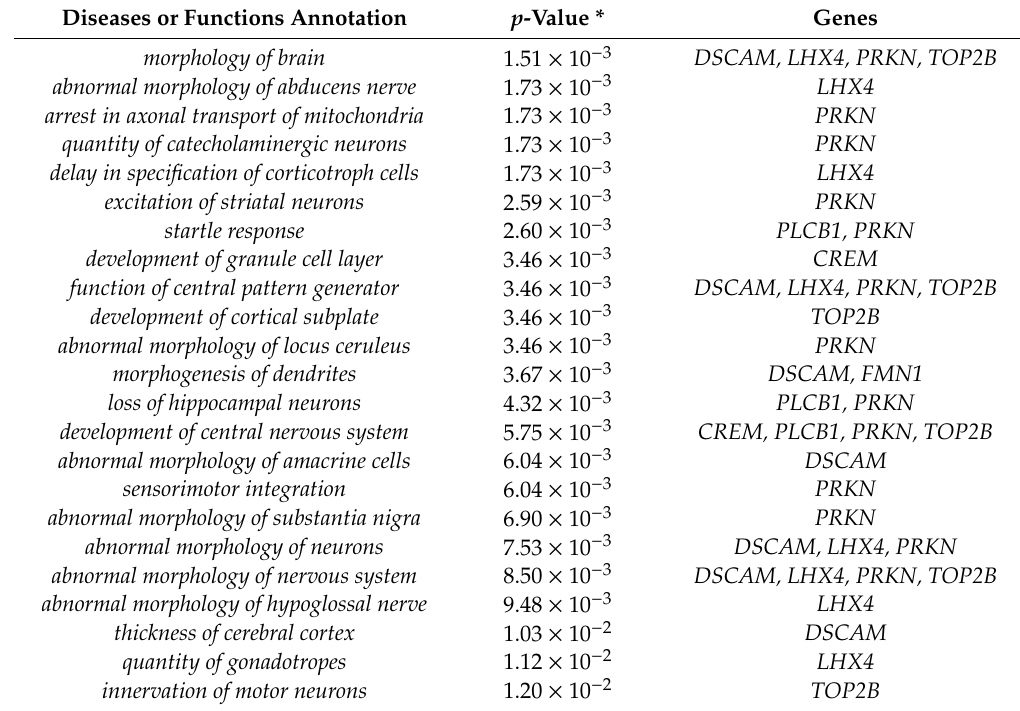
Table 11. Neurological functions implicated by QTN-associated genes in